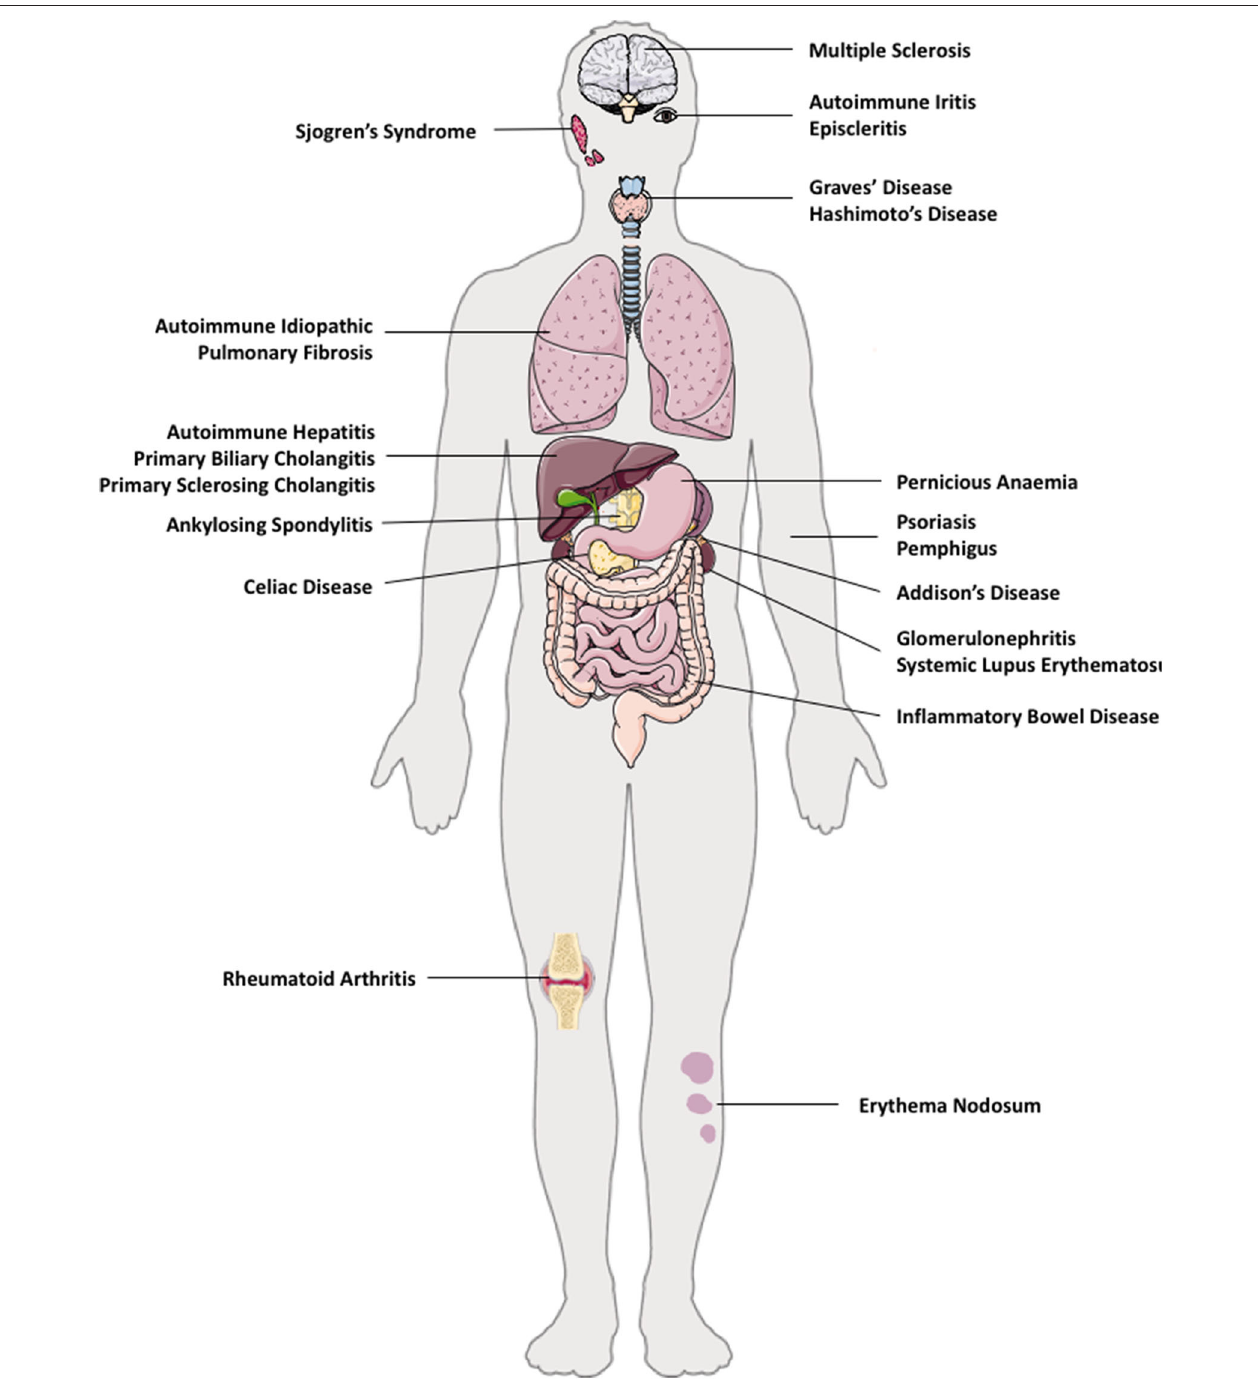
FIGURE 1 | Autoimmune diseases in multiple organs in humans. e.g. autoimmune diseases that can co-exist in multiple tissues are: brain (multiple sclerosis), eye (autoimmune iritis and episcleritis), lung (autoimmune idiopathic pulmonary fibrosis), gut (Coeliac disease, pernicious anemia, inflammatory bowel disease), liver—autoimmune liver diseases (autoimmune hepatitis, primary biliary cholangitis, primary sclerosing cholangitis), kidneys (autoimmune glomerulonephritis), skin (psoriasis, pemphigus), endocrine (autoimmune thyroid disease such as Hashimoto thyroiditis, Graves’ disease, type 1 diabetes, Addison’s disease), and multi-organ involvement, such as systemic lupus